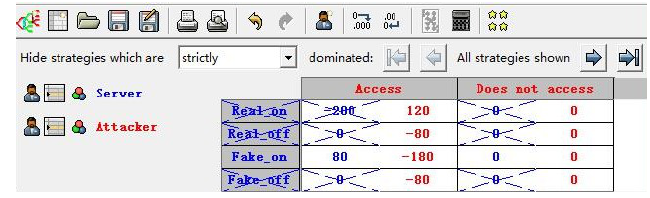
Figure 5. Dominance result when N = 1.